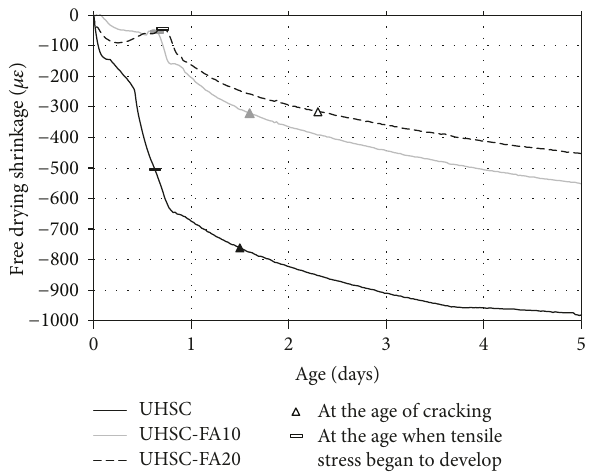
Figure 14: Relationship between restrained cracking and unre- strained drying